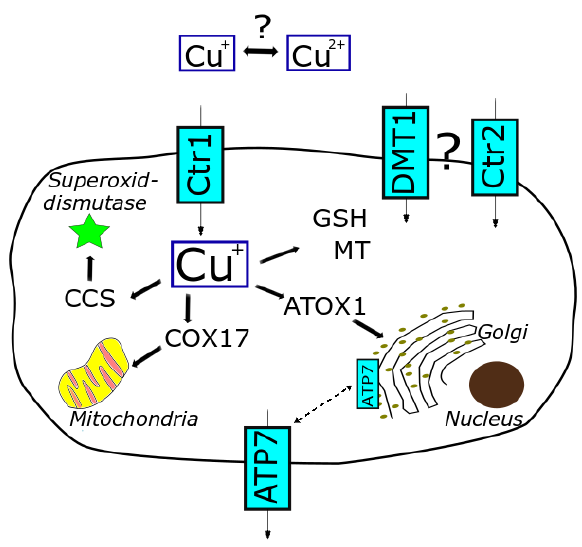
Figure 1. Cellular copper homeostasis, relevant transporters and proteins involved in distribution and tra ffi cking of copper (based on [8,10,30]).